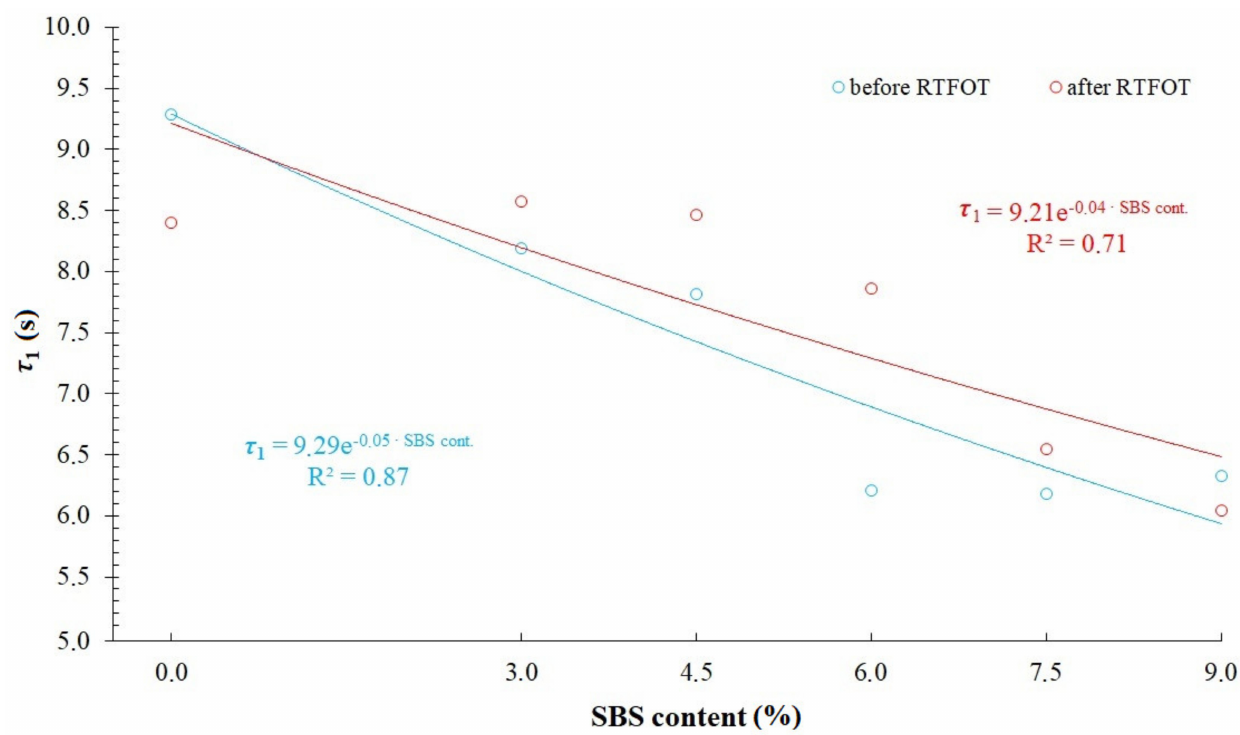
Figure 14. Relaxation time τ 1 = η 1 / E 1 in modified generalized Maxwell model with four parameters.